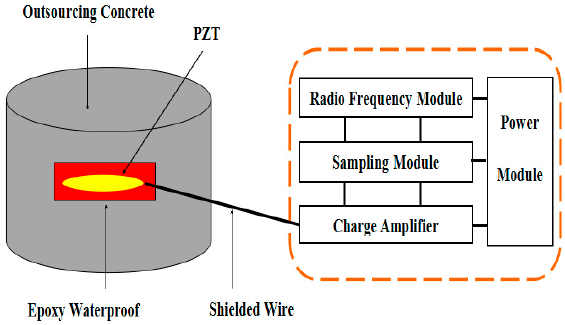
Figure 2. Health monitoring node based on wireless smart aggregates (WSAs).